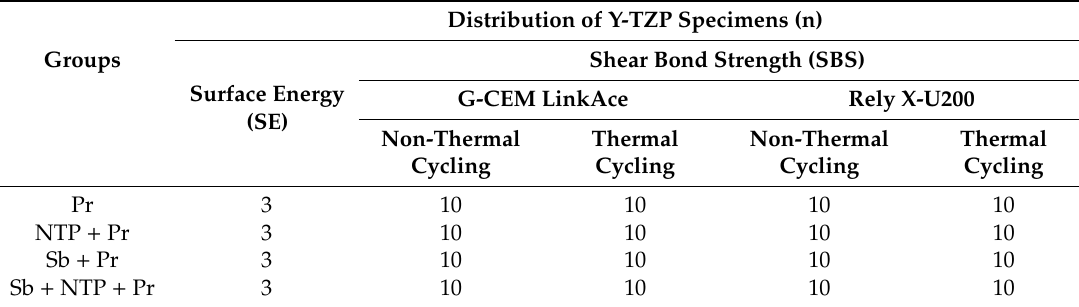
Figure 2. Flowchart of the study design. Table 1. Distribution of Y-TZP specimens for all groups.